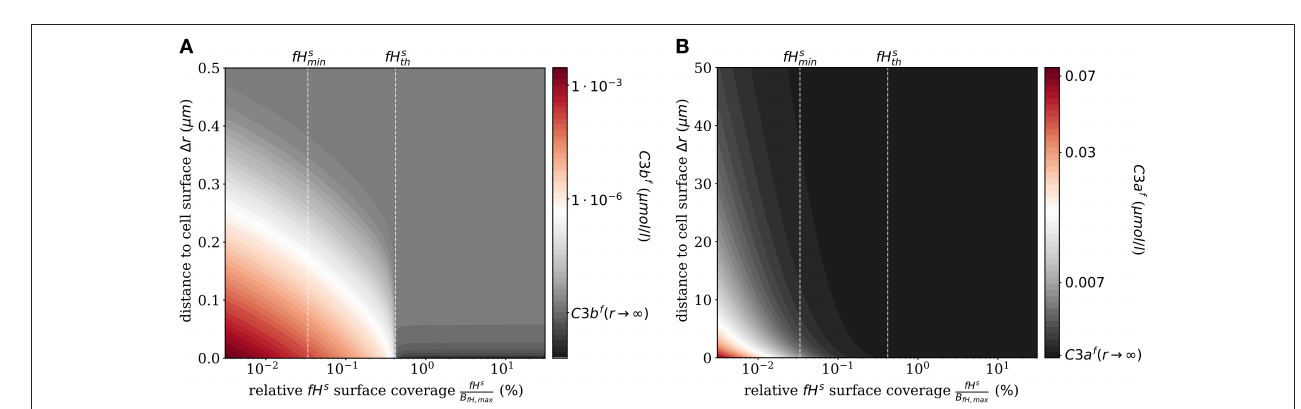
FIGURE 2 | Steady states of the molecules C3b f and C3a f in the fluid phase for varying surface-bound Factor H concentrations. (A) Radial steady state concentration profile of the fluid-phase C3b f concentration. (B) Radial steady state concentration profile of the fluid-phase C3a f concentration. Mind the different scales in (A,B) .